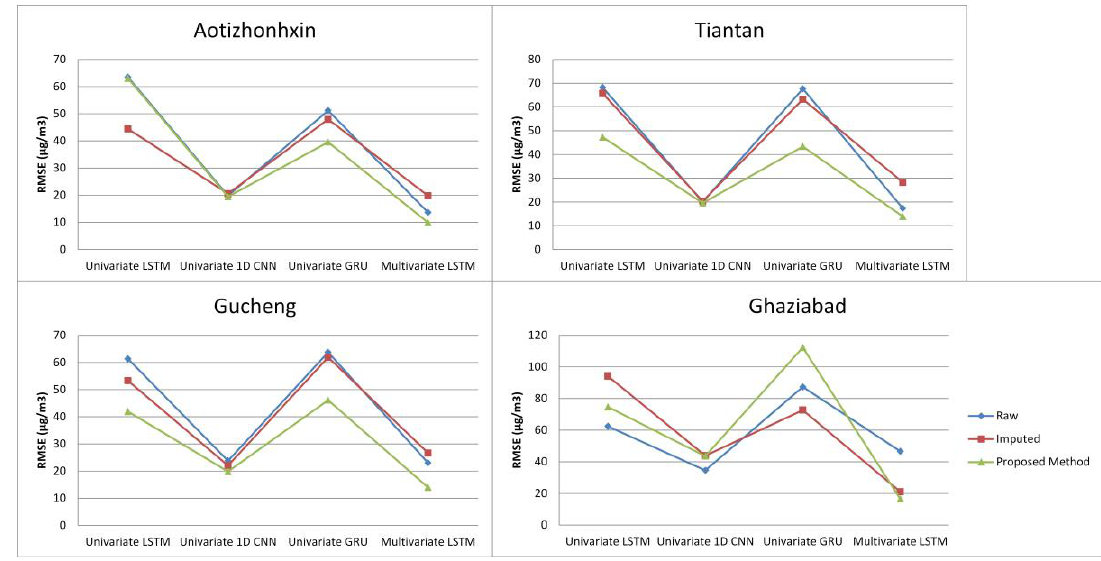
Figure 5. Graphs showing RMSE values for all experimentations. Table 4. Summary of results of experimentation performed on the dataset of four cities.